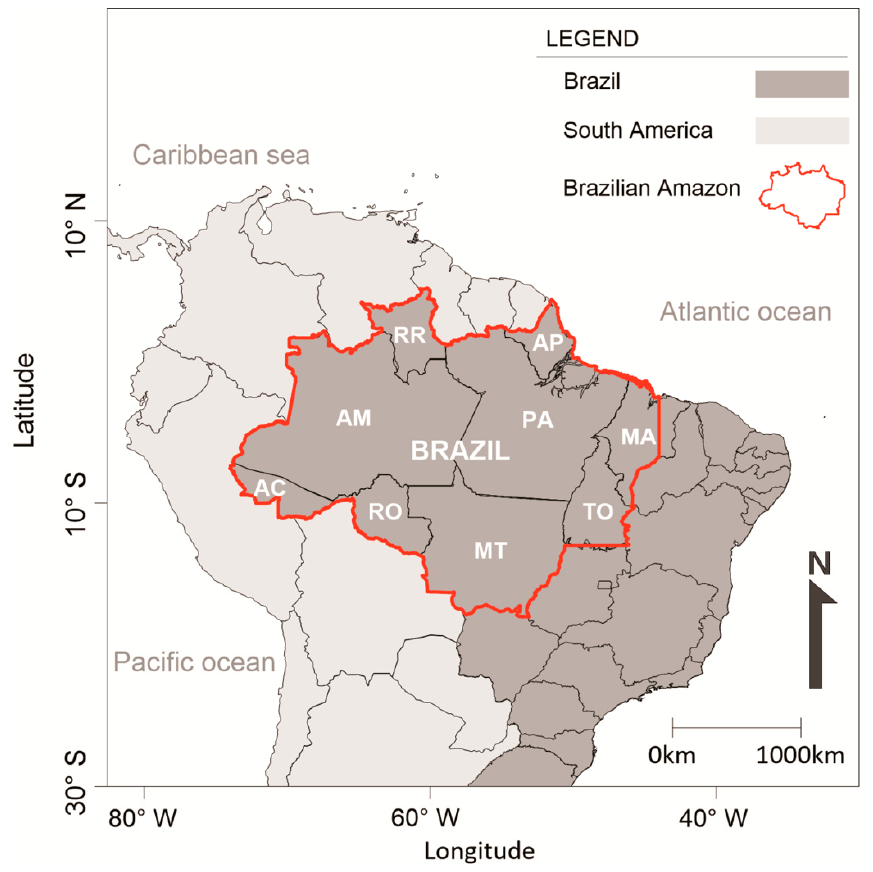
Figure 1. South America and Brazil map highlighting the Amazon region of Brazil (ARB).